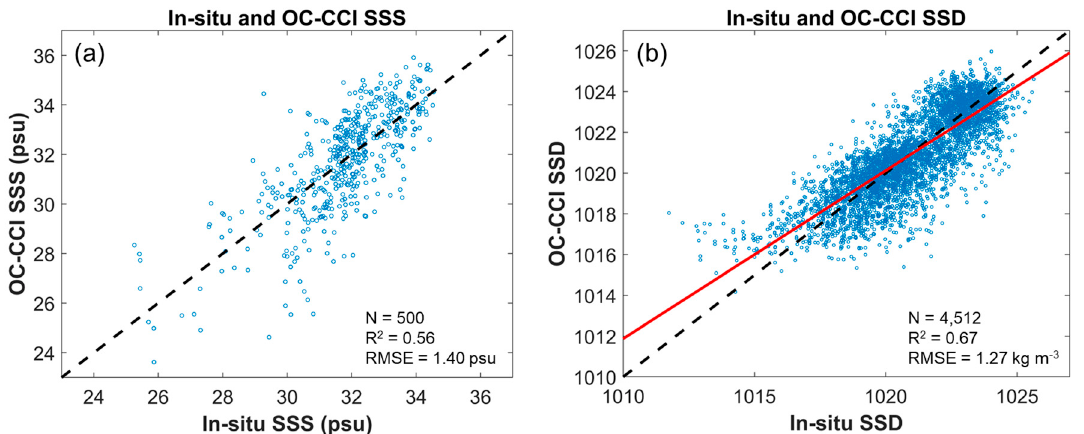
Figure 3. ( a ) Linear fitting by slope and bias scatter diagrams between NIFS serial shipboard measurements and OC-CCI SSS. ( b ) Scatter plot between in situ and OC-CCI SSD. Red line indicates a linear regression line.